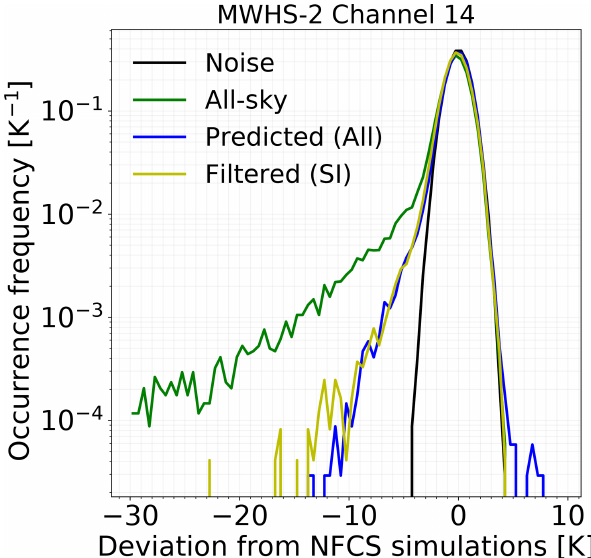
Figure 4. The error distribution for deviations of point estimates from NFCS simulations. The results are from QRNN-single exper- iment 89 + 150GHz and MWHS-2 channel 14. Noise is also plot- ted for reference. The label “All-sky” represents the all-sky simula- tions; “Predicted (All)” denotes the predicted point estimates. The error distribution achieved with scattering index (SI) filtering is also shown (Filtered